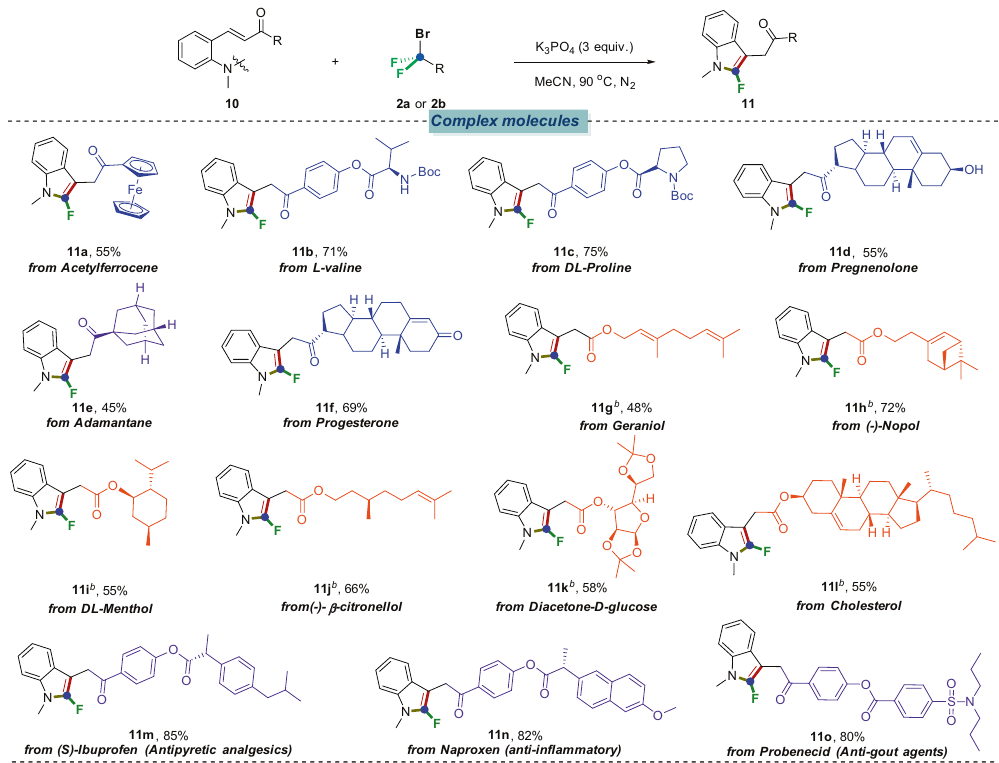
Fig. 5 Scope of complex molecules a . Reaction conditions: a 10 (0.2 mmol), 2a (3 equiv., 0.6 mmol), K 3 PO 4 (3 equiv.), H 2 O (0.1 mL), CH 3 CN (2 mL) under 90 °C for 12 h, N 2 . b 10 (0.2 mmol), 2b (3 equiv., 0.6 mmol), K 2 CO 3 (3 equiv.), CH 3 CN (2 mL) under 90 °C for 12 h, N 2